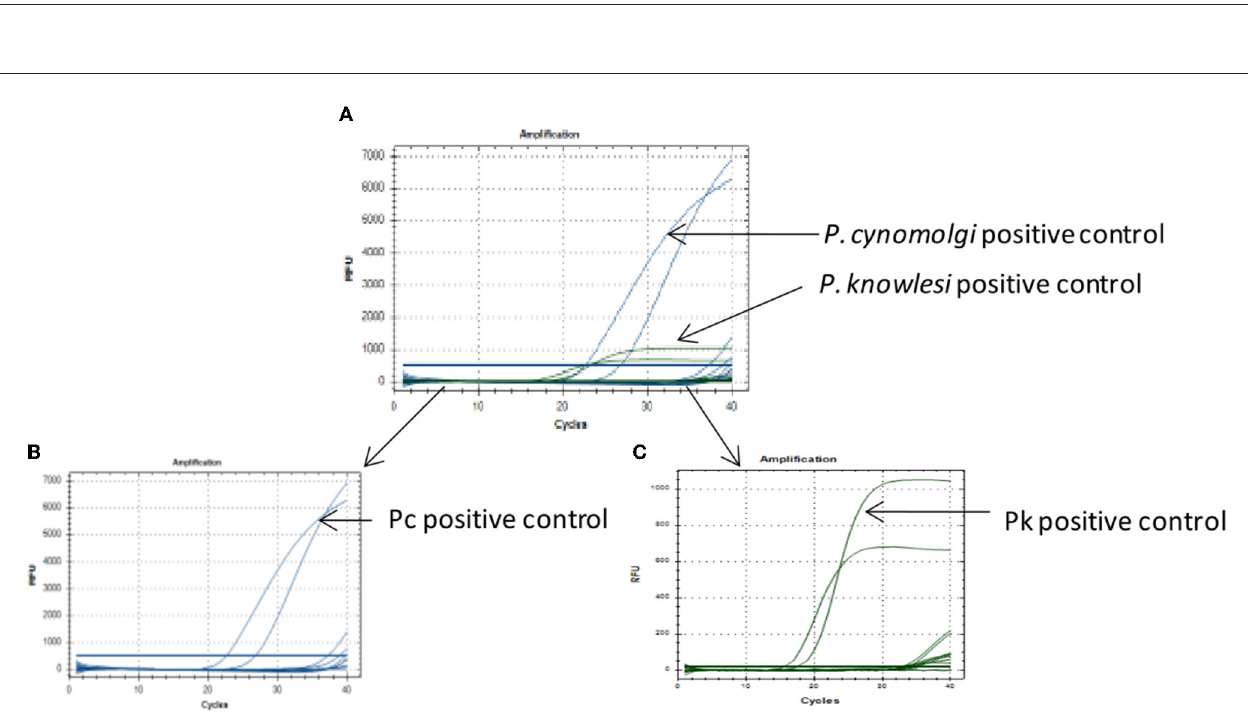
FIGURE2 Specificity of the qPCR assay. (A) Multiplex qPCR assay for detection of Pk and Pc parasites DNA as positive controls, while templates from Pf, Pv, Pm and Po parasites DNA did not amplify. (B) Selected fluorophore probe FAM (blue) for P.cynomolgi showed good amplification but no amplification for Pf, Pv, Pm, and Po. (C) Selected fluorophore probe HEX (green) for P. knowlesi showed good amplification but no amplification for Pf, Pv, Pm, and